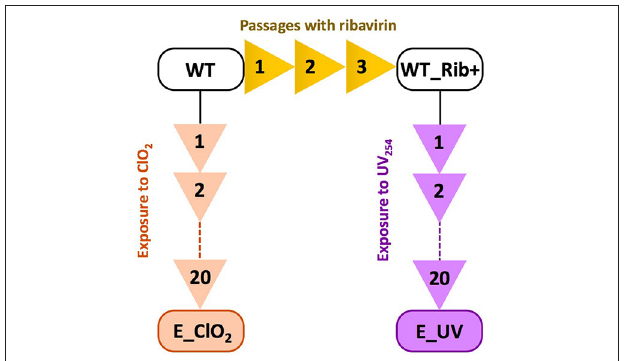
FIGURE 1 | Overview over the experimental evolution lineages to produce resistant populations E_ClO 2 and E_UV from their wild-types WT or WT Rib + .